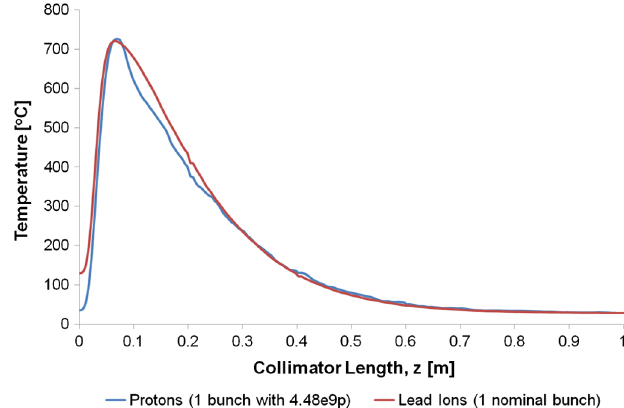
FIG. 13. Temperature peak profiles within the jaw inserts along the beam direction for heavy ions and